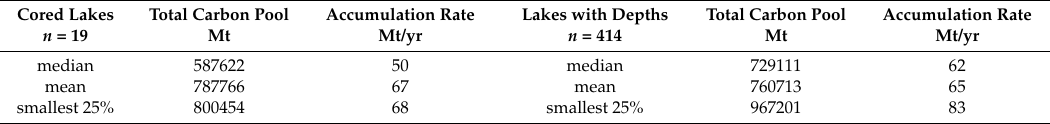
Table 5. Estimates of the Total Carbon Pool in Uinta